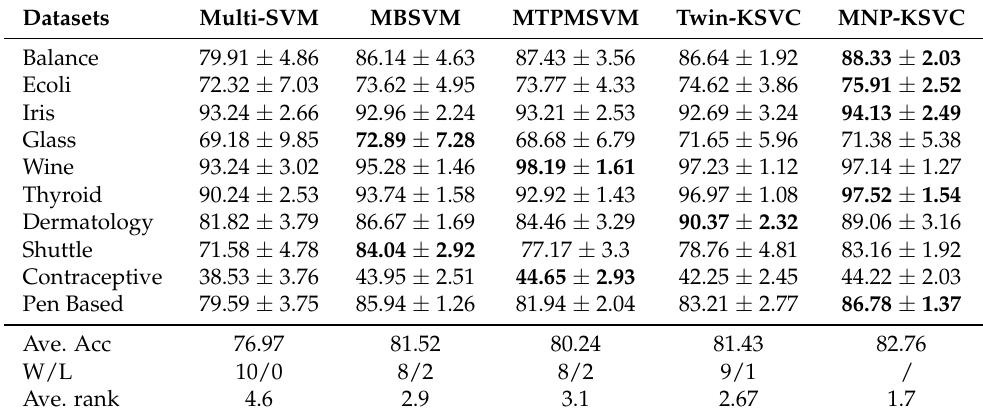
Table 2. Performance comparison on benchmark datasets for linear classifiers, in terms of mean ± std of the testing multiclass accuracy (%). The Win/Loss (W/L) denotes the number of datasets for which MNP-KSVC is superior/inferior to the compared classifiers. Ave. Acc and rank denote each classifier’s average accuracy and rank over all